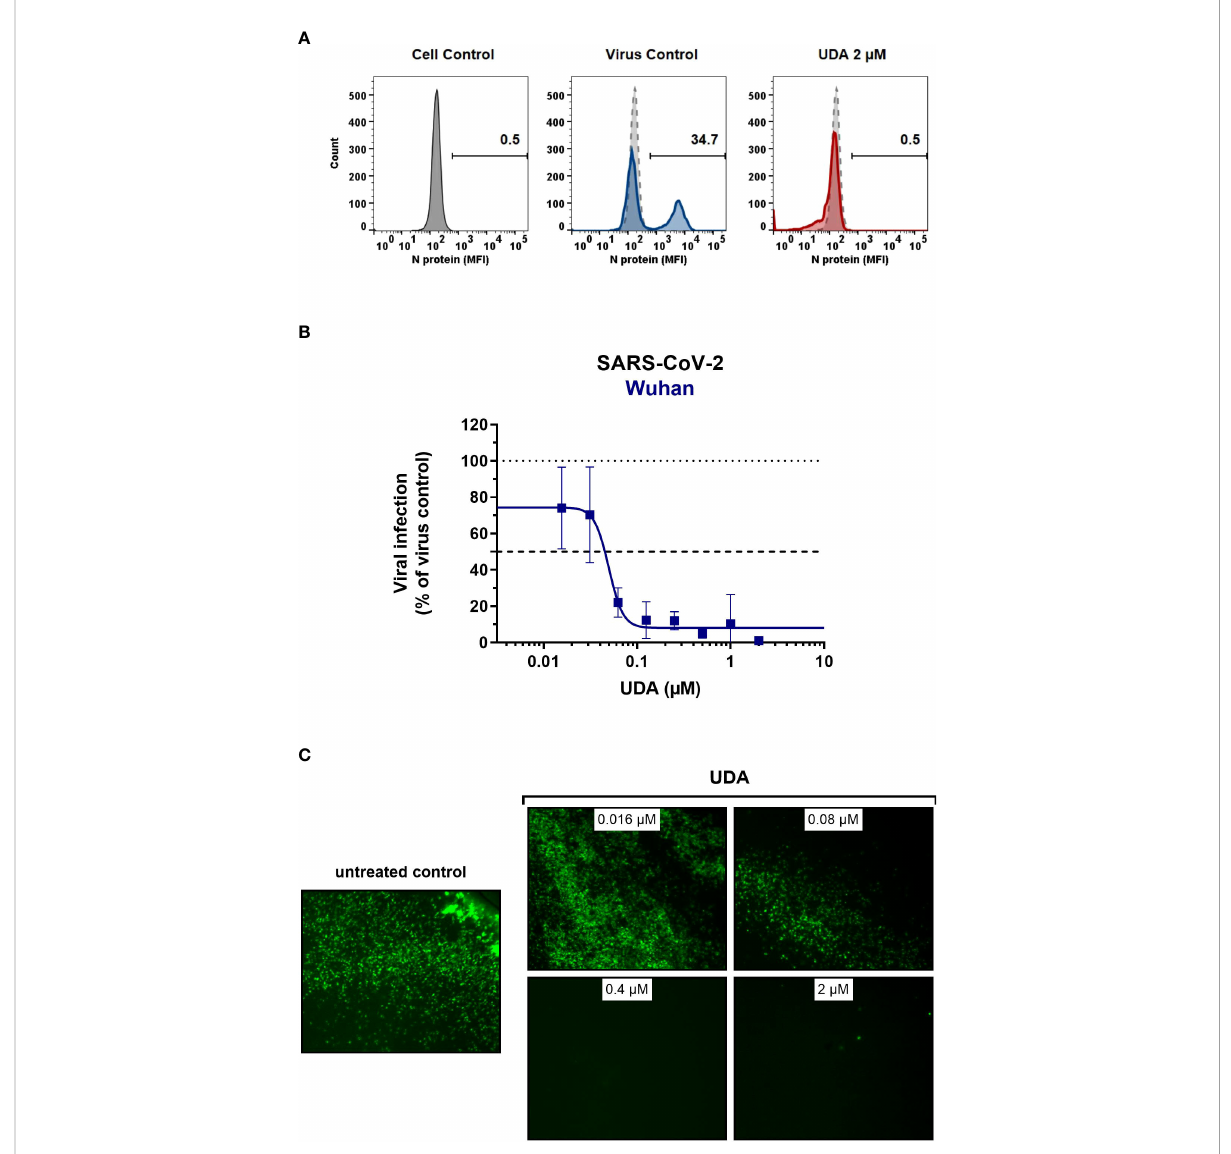
FIGURE 3 Antiviral activity of UDA against live SARS-CoV-2 virus in A549 cells and primary ALI cultures. (A, B) A549.ACE2 + -TMPRSS2 cells were exposed to SARS-CoV-2 (WT Wuhan-Hu-1) in the absence or presence of UDA. (A) SARS-CoV-2 replication was assessed by fl ow cytometry. Cells infected with SARS-CoV-2 in the absence or presence of UDA (2 µM) were collected at 48h p.i. and stained intracellularly for the viral N protein. Histogram plots show mean fl uorescence intensity (MFI) values of N expression in noninfected (Cell Control; grey), infected (Virus Control; blue) and UDA-treated infected (red) cells from a representative experiment. Single cell analysis was performed on 8,000 – 10,000 cells by fl ow cytometry. The numbers in each plot refer to the percentage of cells that stained positive for N (i.e., infected cells). The dashed grey histogram plot represents the background signal from the non-infected cell control. (B) SARS-CoV-2 replication was assessed by RT-qPCR analysis of the viral copy numbers of the N gene in the supernatant at day 3 post infection (p.i.). RT-qPCR data were used to calculate the % inhibition of viral replication and to plot a concentration-response curve for UDA. Graphs show data of 3 independent experiments with 2 technical replicates each (mean ± SD; n=6). (C) Human primary lower (SmallAir) airway epithelial ALI cultures were infected apically with a GFP-expressing SARS- CoV-2 variant (Wuhan-Hu-1) for 2h in the absence or presence of UDA, washed and exposed to air. Pictures, taken at 4 days post infection, show GFP expression in the infected cells. Representative pictures from a biological replicate out of two are